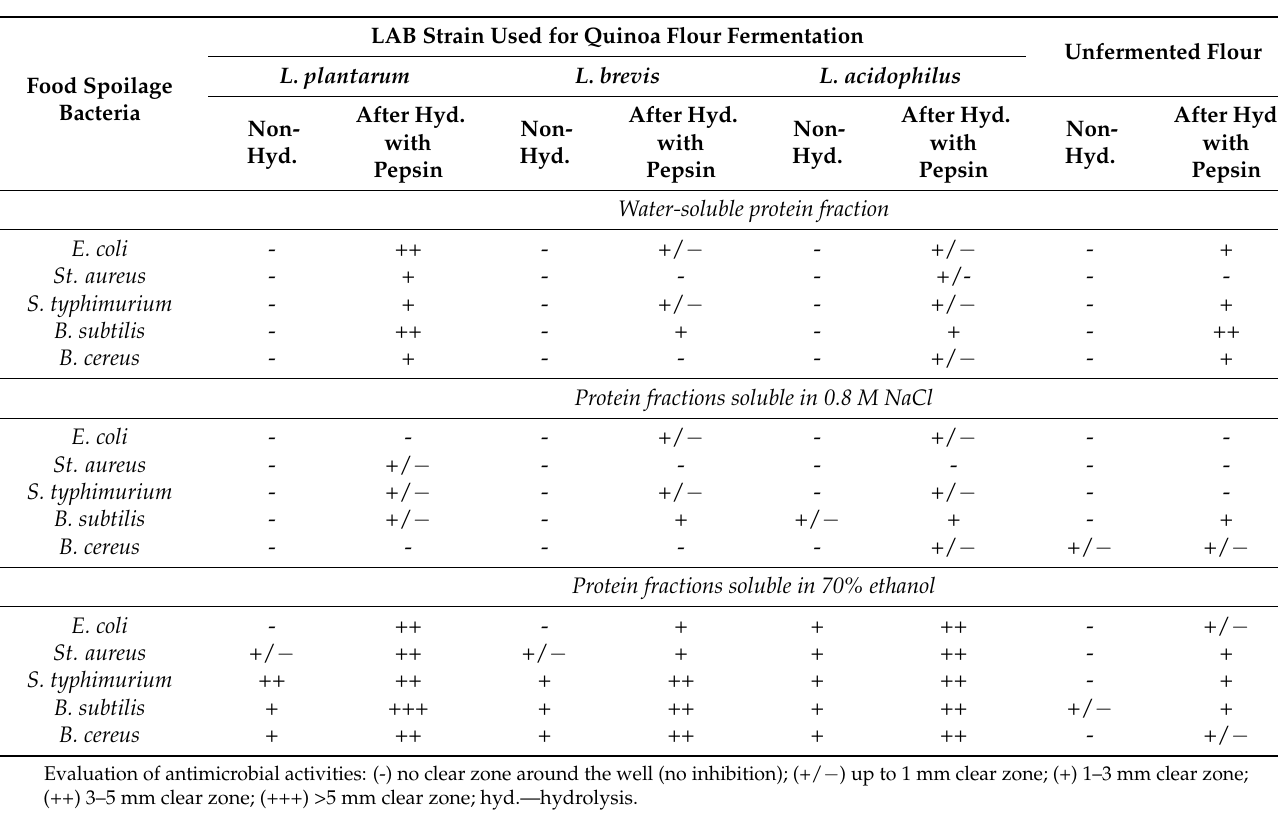
Table 3. Influence of fermentation with LAB and enzymatic hydrolysis with pepsin on antimicrobial properties of protein fractions from quinoa.